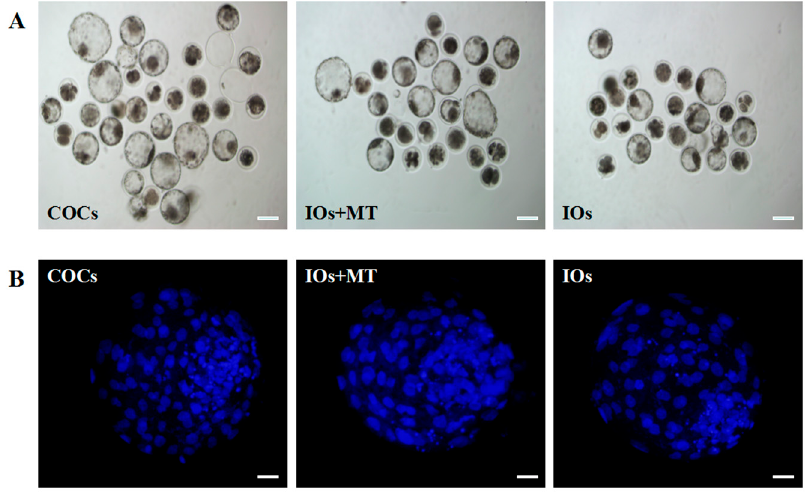
Figure 7. Effects of melatonin on IVF embryo developmental potential and cell number of blastocysts. ( A ) Epifluorescence photomicrographs of in vitro-produced bovine blastocysts. COCs, cumulus–oocyte complexes; IOs, inferior bovine oocytes; MT, melatonin; scale bar = 100 μ m. ( B ) Nuclear staining of bovine blastocyst after IVF in different groups. Scale bar = 20 μ m.